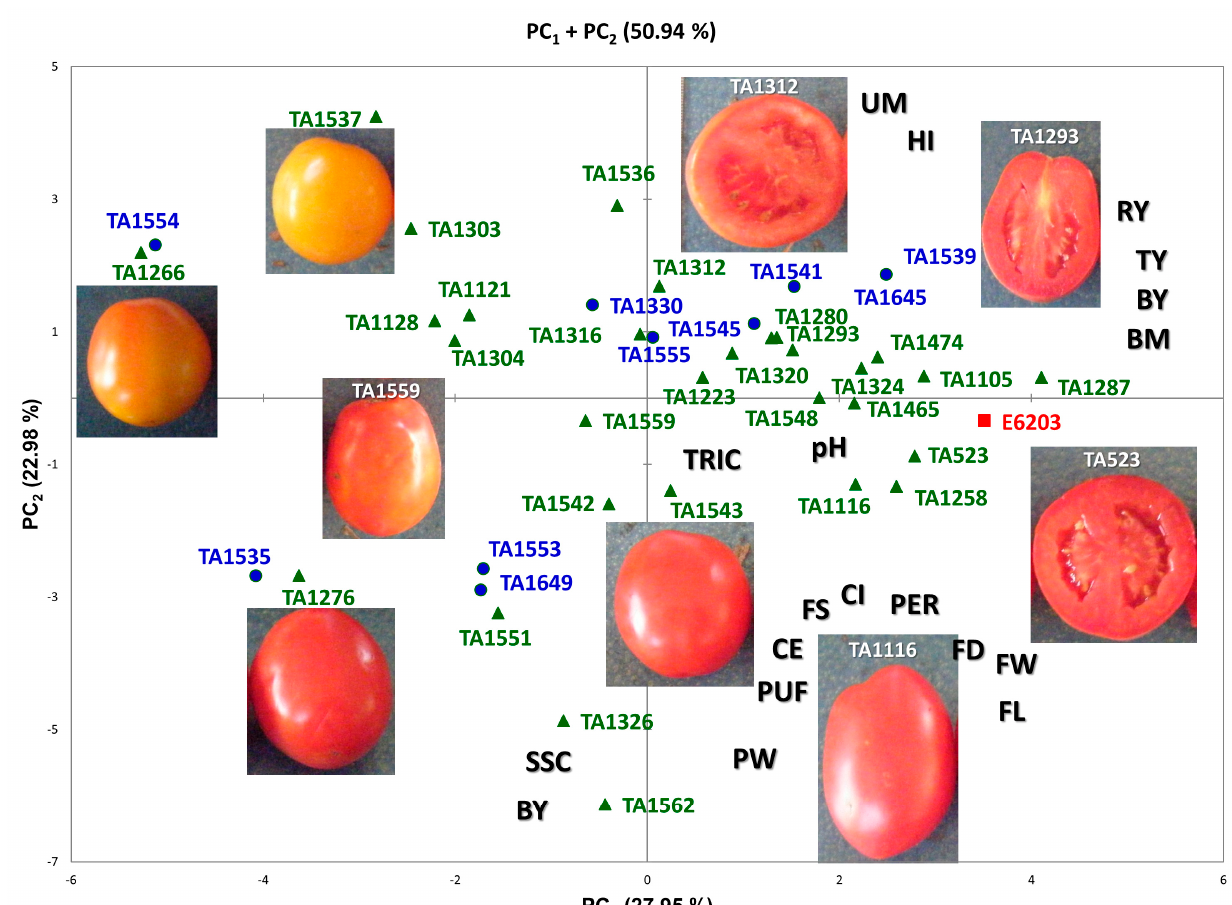
Figure 2. Phenotypic variability in the studied introgression lines and the recurrent parent. Loading plot of the first (PC 1 ) and second (PC 2 ) principal components showed the variations for the 19 morphological and agronomic traits in the set of 39 introgressions lines and the control (cv E6203) Introgressions lines (ILs) carrying single introgressions are indicated in green font with a triangle symbol, whereas ILs carrying multiple fragments are indicated in blue font with a circular symbol. The control is indicated with a square in red font. The direction and distance from the center of the biplot indicate how each trait contributes to the first two components. The explanation for trait acronyms is reported in Table 3.